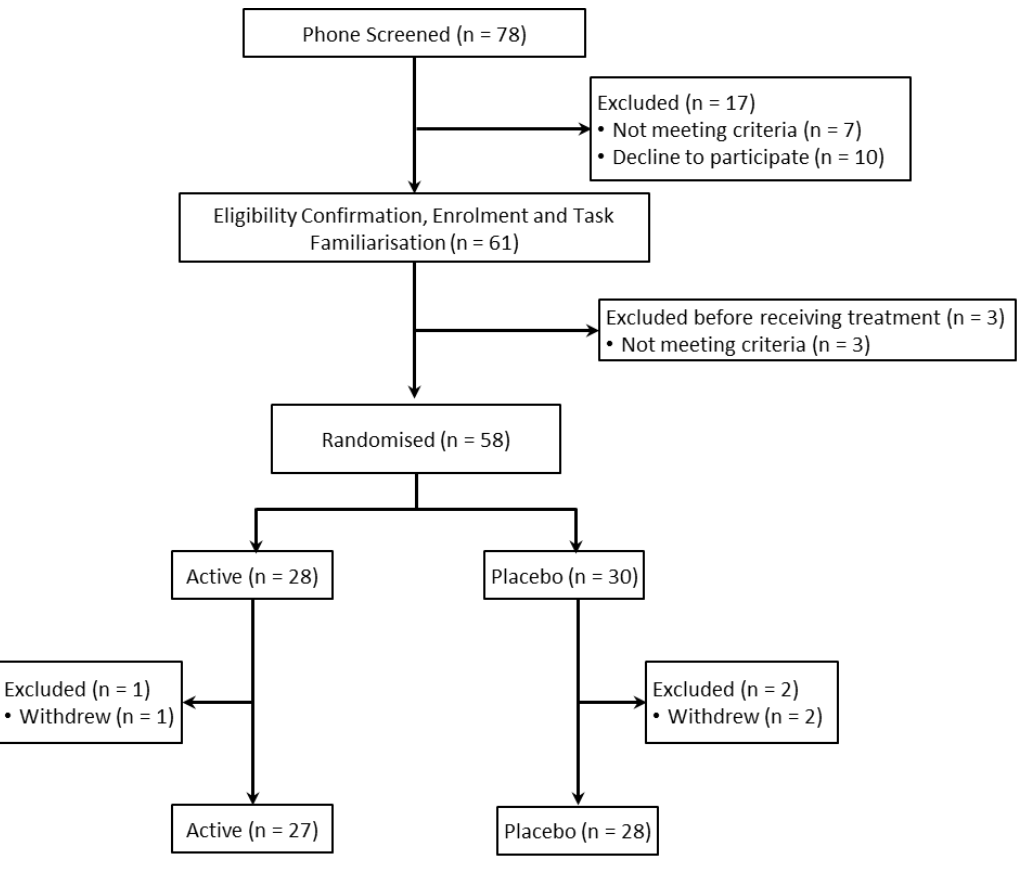
Figure 1. Flow of participants through the trial.